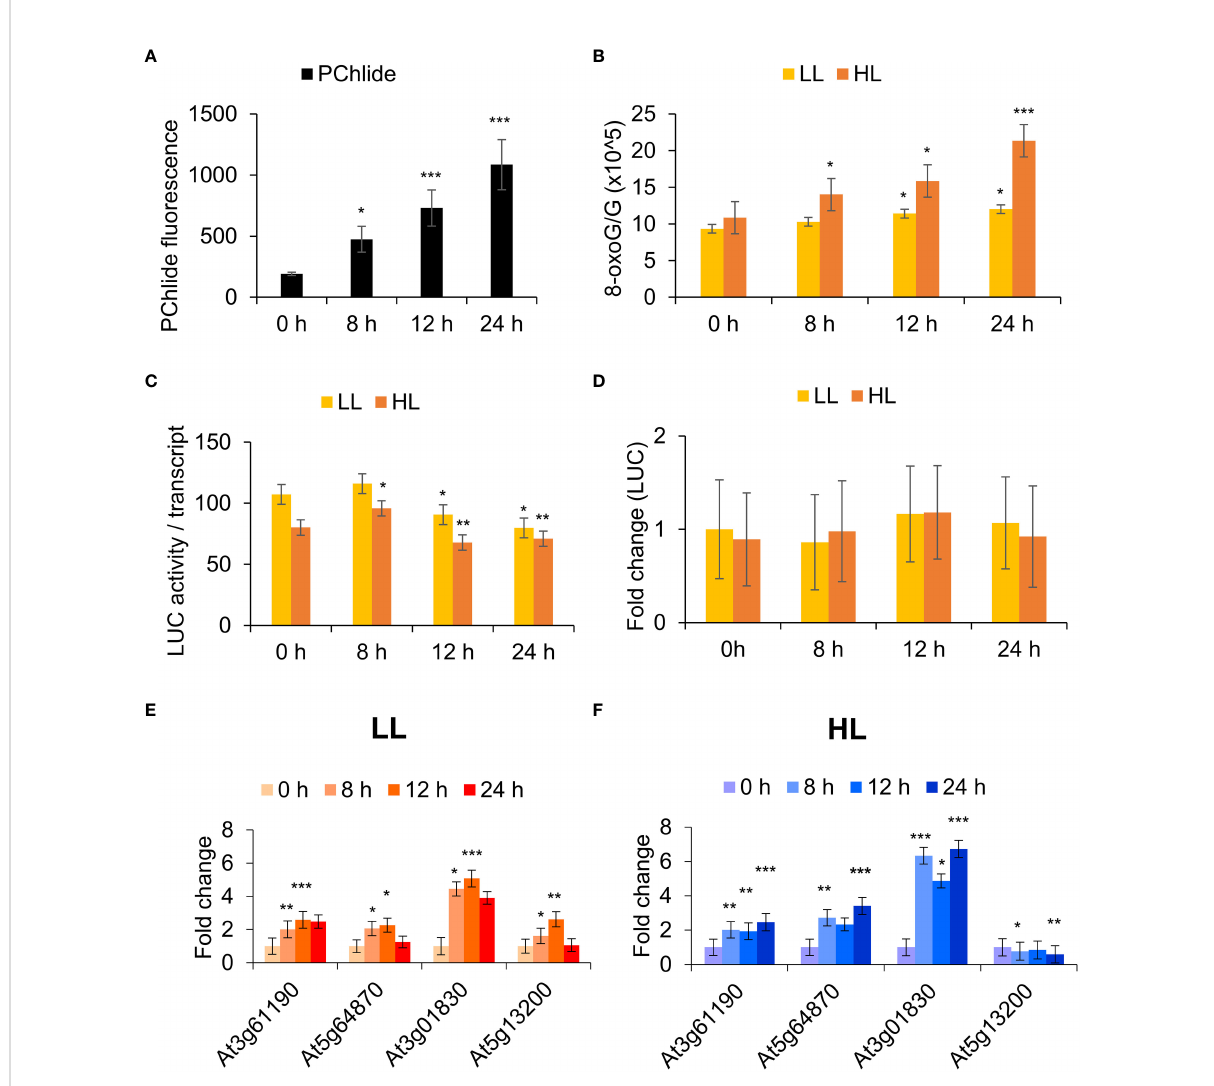
FIGURE 3 RNA oxidation in the fl u mutant is correlated with dark incubation time and light intensity. (A) Protochlorophyllide (Pchd) accumulation in fl u x UBIQ10:IAA-LUC seedlings. Fluorescence was measured in dark incubated fl u x UBIQ10:IAA-LUC seedlings using a fl uorimeter (Ex/Em: 440/630 nm). The means and SE of 24 whole seedlings per time point are shown. (B) RNA oxidation analysis. Arabidopsis (Col-0, fl u x UBIQ10:IAA-LUC) seedlings were incubated in the dark for 0, 8, 12, 24 h in the dark before 30 min exposure to low light (LL, 30 µE m-2 s-1) or high light (HL, 1000 µE m-2 s-1). RNA was processed for RNA oxidation as described in the Methods. (C) RNA translatability analysis. RNA as in (B) was used for in vitro translation and luciferase activity analysis as described in the Methods. Values were normalized against luciferase transcript levels, and Student ’ s t-test performed against LL 0 h. (D) RNA as in (B) was processed as described in the Materials and Methods for qRT-PCR analysis to determine fold change in luciferase mRNA levels in the various samples using luciferase speci fi c primers. (E) and (F) RNA as in (B) was extracted and processed as described in the Materials and Methods for qRT-PCR analysis. The means and SE of three replicates is shown. Student ’ s t-test was performed against their respective controls for signi fi cance (* - P<0.05; ** - P<0.01; *** - P<0.001). 1 O 2 sensitive genes: At3g61190 – Bonsai associated protein (BAP1), At5g64870 - nodulin-related protein, At3g01830 - calmodulin-related protein, At5g13200 - GRAM domain- containing